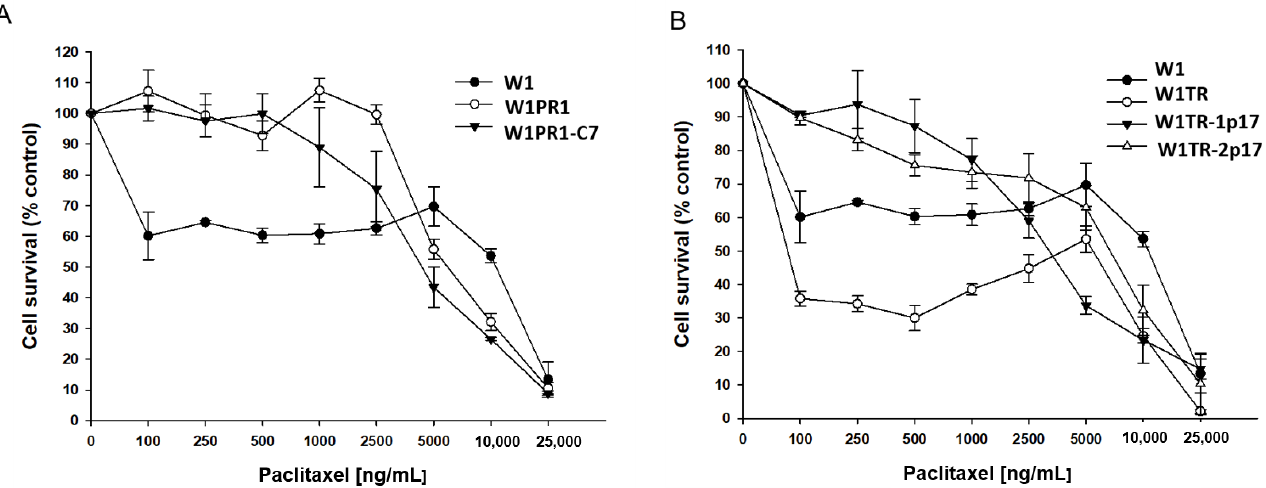
Figure 9. MTT cell survival assay in 3D cell culture conditions in W1, W1PR1 and W1PR1-C7 cell lines ( A ) and W1, W1TR, W1TR-1p17, W1TR-2p17 cell lines ( B ). Cells were seeded in 96-well plates with non-adherent surface and treated with or without increasing concentration of PAC (paclitaxel)